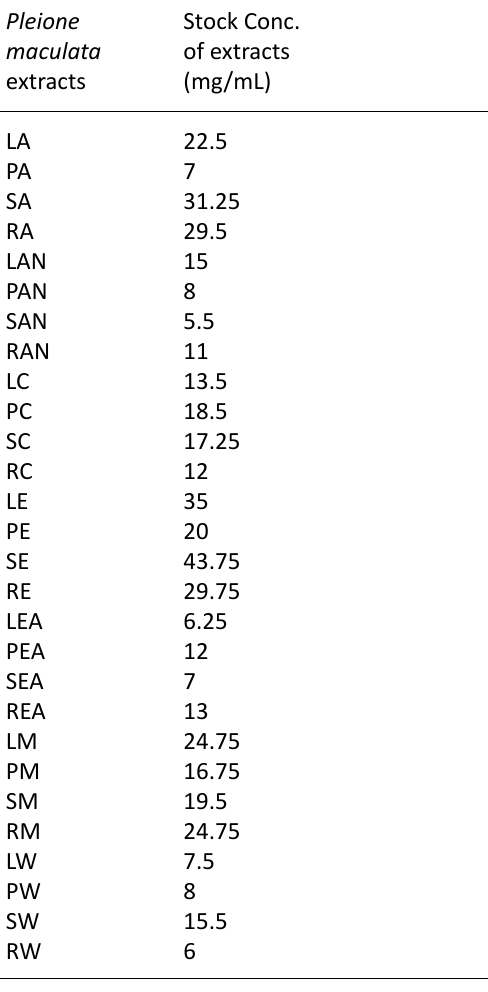
table 1. Stock concentration of P. maculata extracts Pleione Stock Conc. maculata